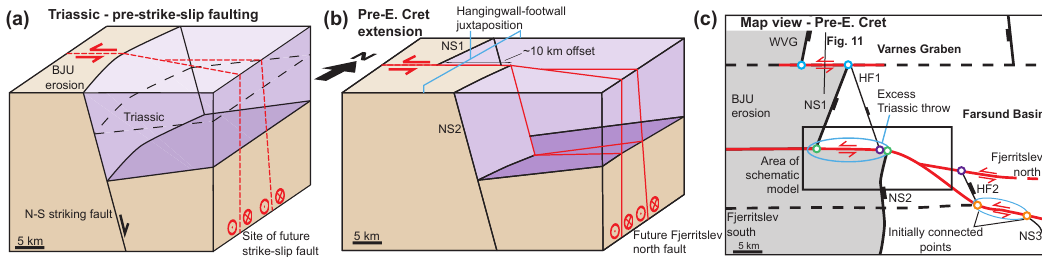
Figure 10. (a) Schematic diagram showing Triassic activity along N–S-striking faults. (b) Schematic diagram showing the resultant fault geometries and associated hangingwall–footwall juxtaposition as a result of the sinistral offset of the N–S-striking fault. (c) Map showing the geometry of the strike-slip system within the Farsund Basin prior to the Early Cretaceous. The black box shows the location of the schematic model showing hangingwall–footwall juxtaposition, with blue ovals showing areas of excess Triassic throw (see Figs. 7, 8).